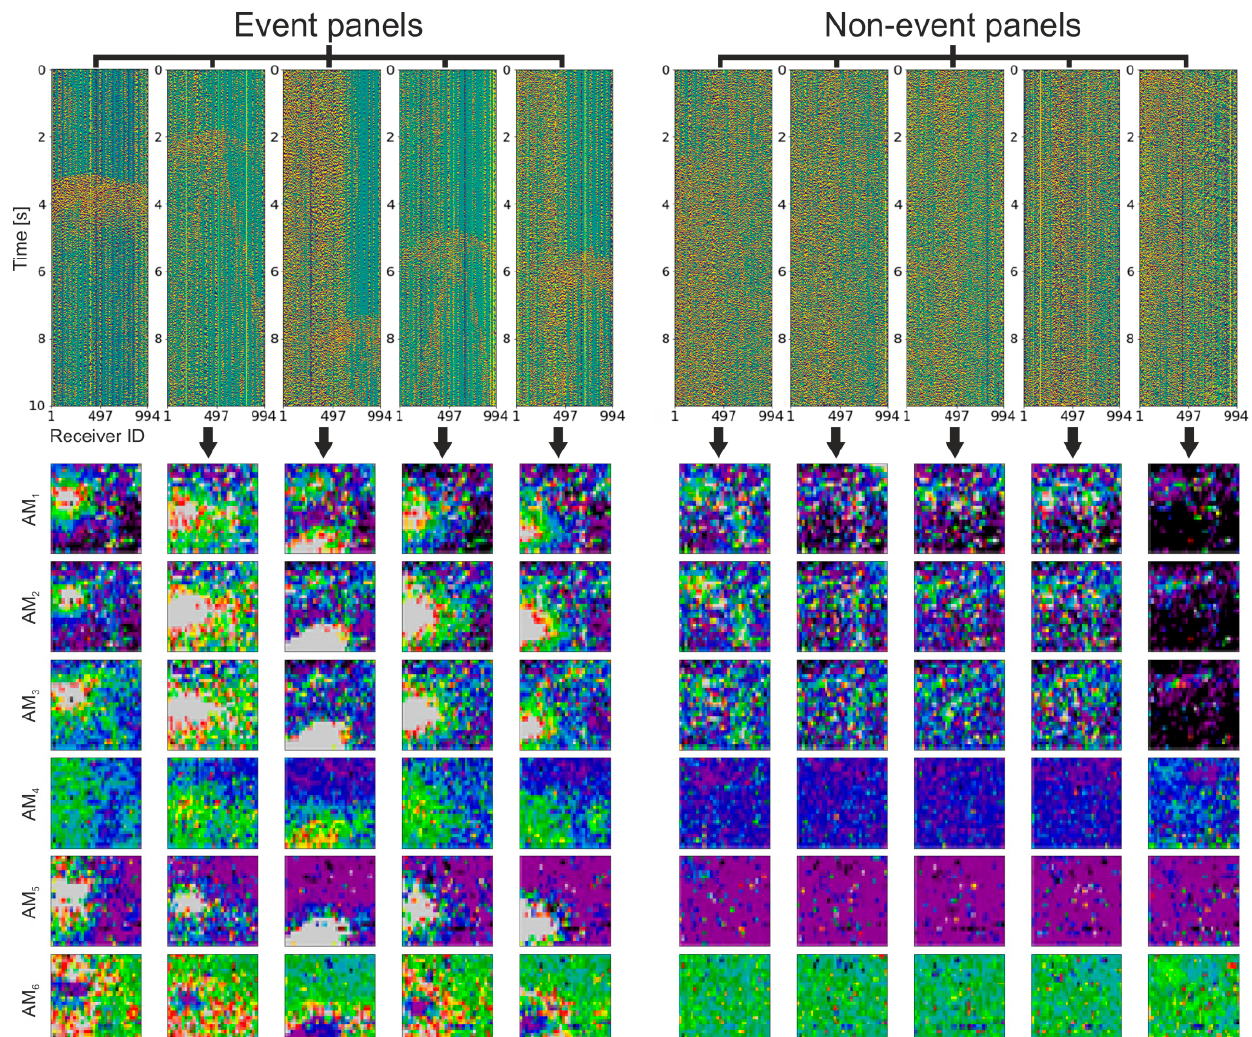
Figure 3. Transformation of the arbitrarily selected noise panels with/without body–wave energy into their image representations achieved through the defined set of attribute maps (AMs). The AM subscript corresponds to the same order in which derivation of the attribute values (ATVs) is shown in Figure 2. The attribute maps on the left are the examples of the body–wave image class in the labeled training set while the attribute maps on the right demonstrate the “noise” image class.